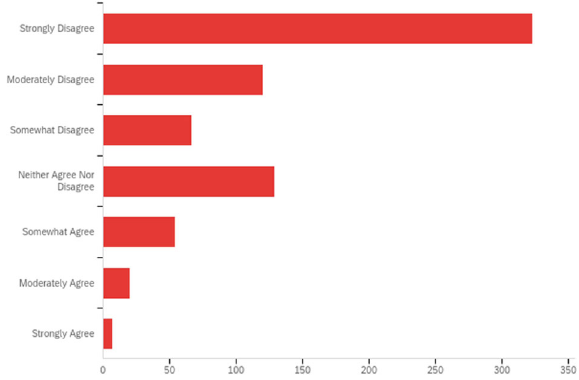
Fig. 10 Hesitants agreeing to vaccinate in order to attend events with large